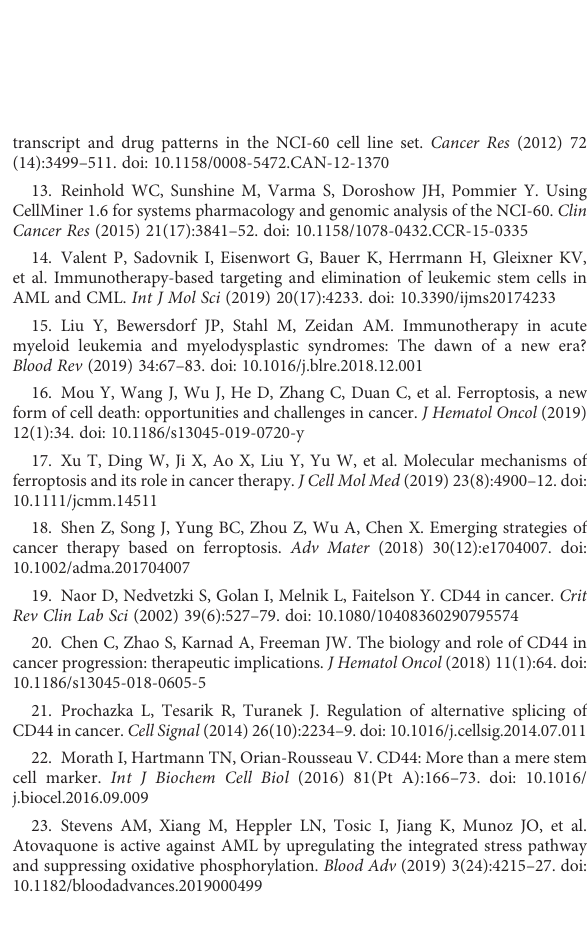
SUPPLEMENTARY FIGURE 1 (A) Tenfold cross-validation for tuning parameter selection in the LASSO model. The solid vertical lines represent partial likelihood deviance ± standard error (SE) values. (B) LASSO coef fi cient pro fi les for the 18 DEFRGs. SUPPLEMENTARY FIGURE 2 The mRNA expression levels of 10 genes in AML patients (n = 20) and healthy donors (n = 20). SUPPLEMENTARY TABLE 1 60 FRGs utilized in this study that were obtained from the previous literature. SUPPLEMENTARY TABLE 2 The DEGs between healthy donor and AML patients. SUPPLEMENTARY TABLE 3 The DEGs between the low- and high-risk groups. SUPPLEMENTARY TABLE 4 The primer sequence of 10 genes in our signature for